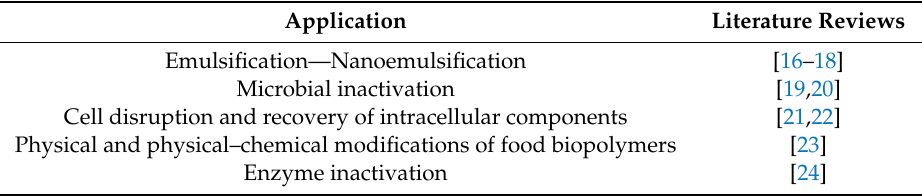
Table 1. Recent reviews on specific applications of high pressure